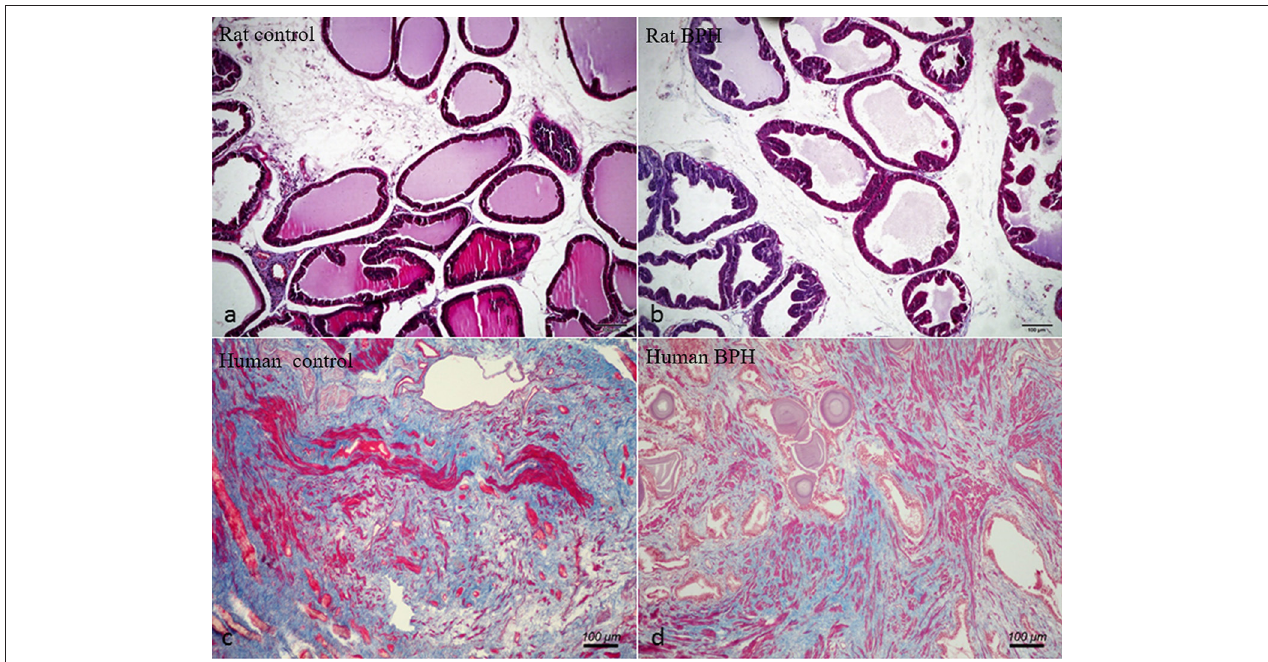
FIGURE 3 | Masson’s trichrome staining of prostate tissue. Prostatic SM cells were stained red, collagen fibers were stained blue and epithelial cells were stained orange. (a) Normal rat prostate. (b) BPH rat prostate. (c) Normal human prostate. (d) BPH human prostate (magnification × 100, n = 9 for each